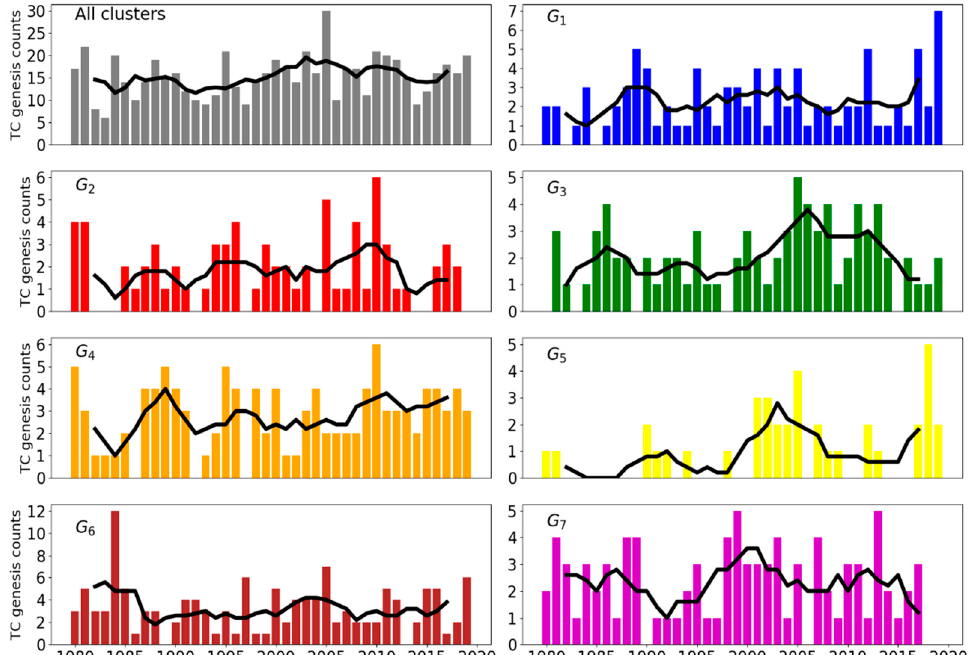
Figure 3. Annual TC genesis counts for the whole NATL basin and for each cluster. The bold line shows the time series filtered with a centered 5-yr moving window. G N (N = 1, 2, 3, 4, 5, 6, 7) represents each genesis cluster.